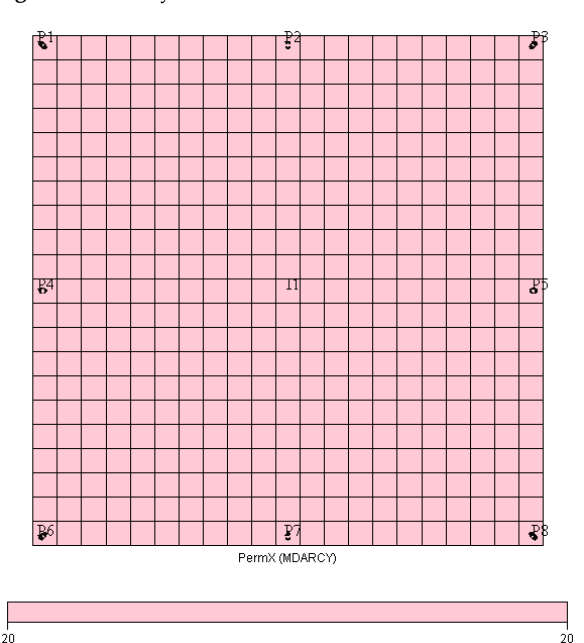
Figure 4. Porosity model.